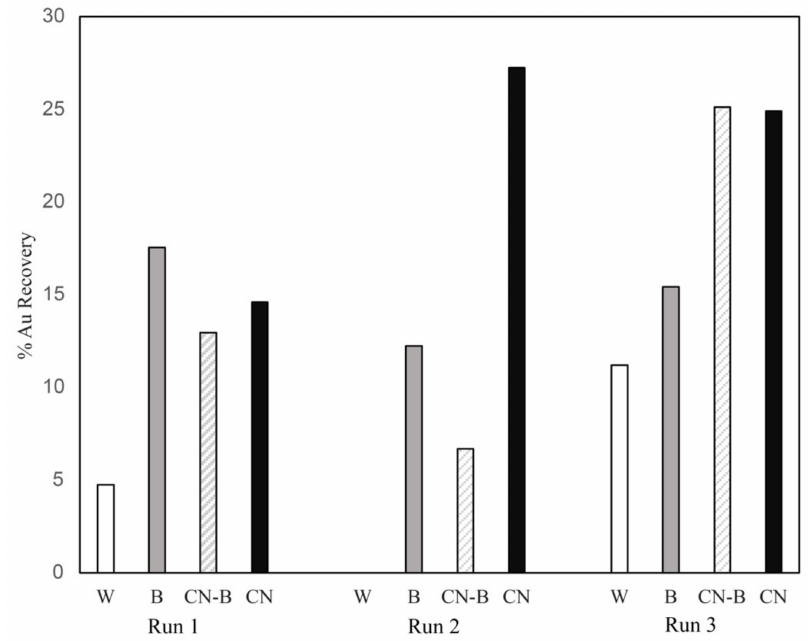
Figure 6. Percent gold recovery for each of the three runs (100% × Total mass Au in effluents/Sum of Au in effluents + tailings after treatment). W = water; B = bacteria; CN-B and CN =